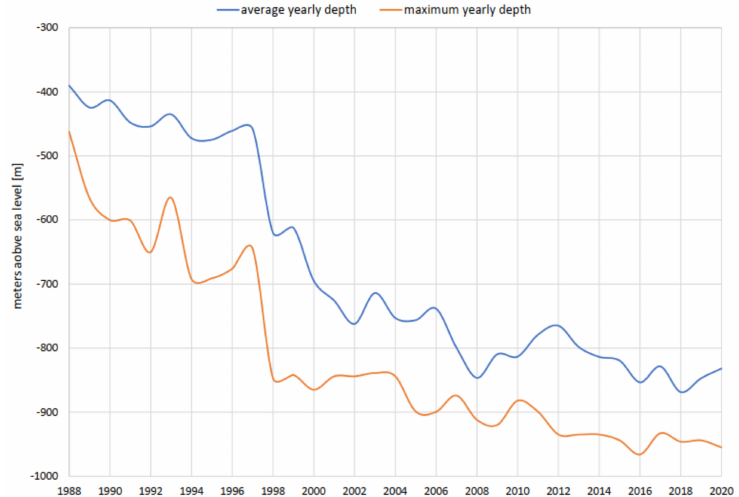
Figure 10. Changes in the average and total depth of the coal output from